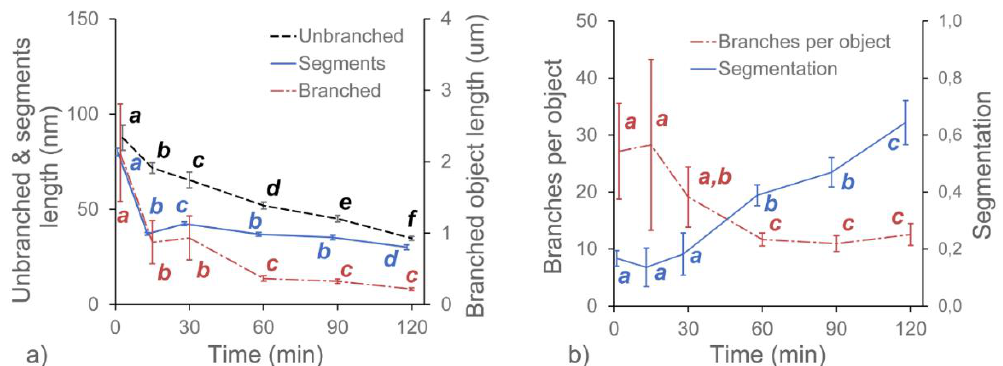
Figure 5. Changes in the average values of the structural parameters of DASP treated with ABF with respect to the duration of enzyme treatment. Different letters indicate significant differences (according to ANOVA with p = 0.05). Bars indicate 95% confidence intervals for mean values.